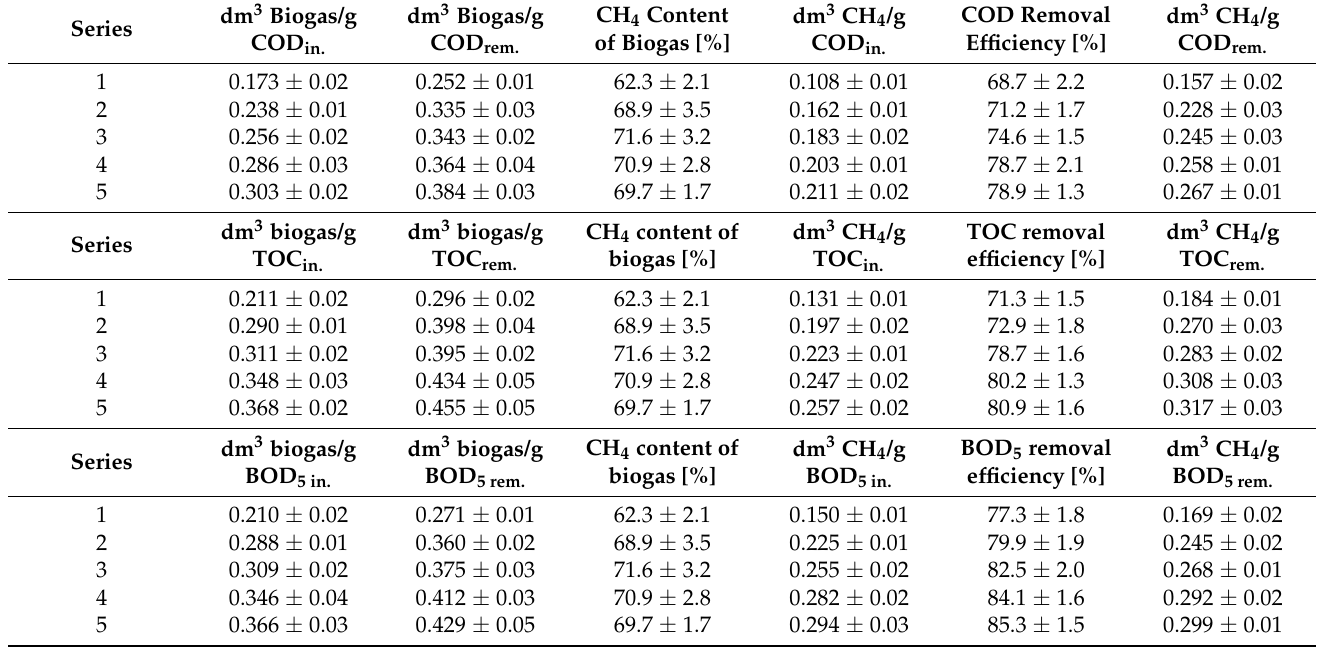
Table 7. Methane and biogas production rates by unit of contaminant